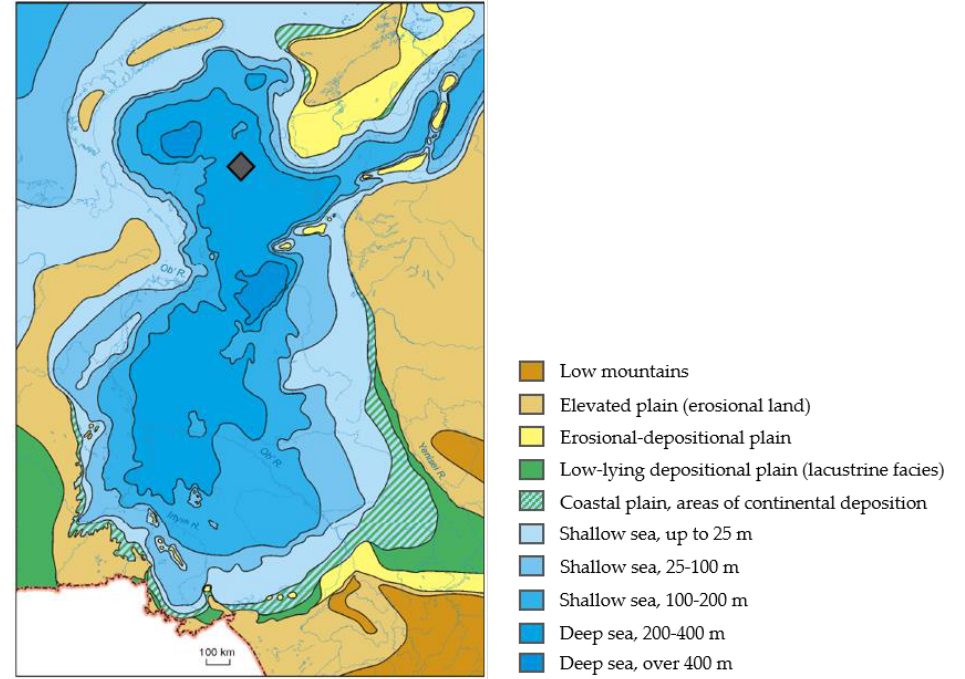
Figure 12. Paleogeography of the studied area (dark rhomb) in the Tithonian modified after Kontorovich [3].